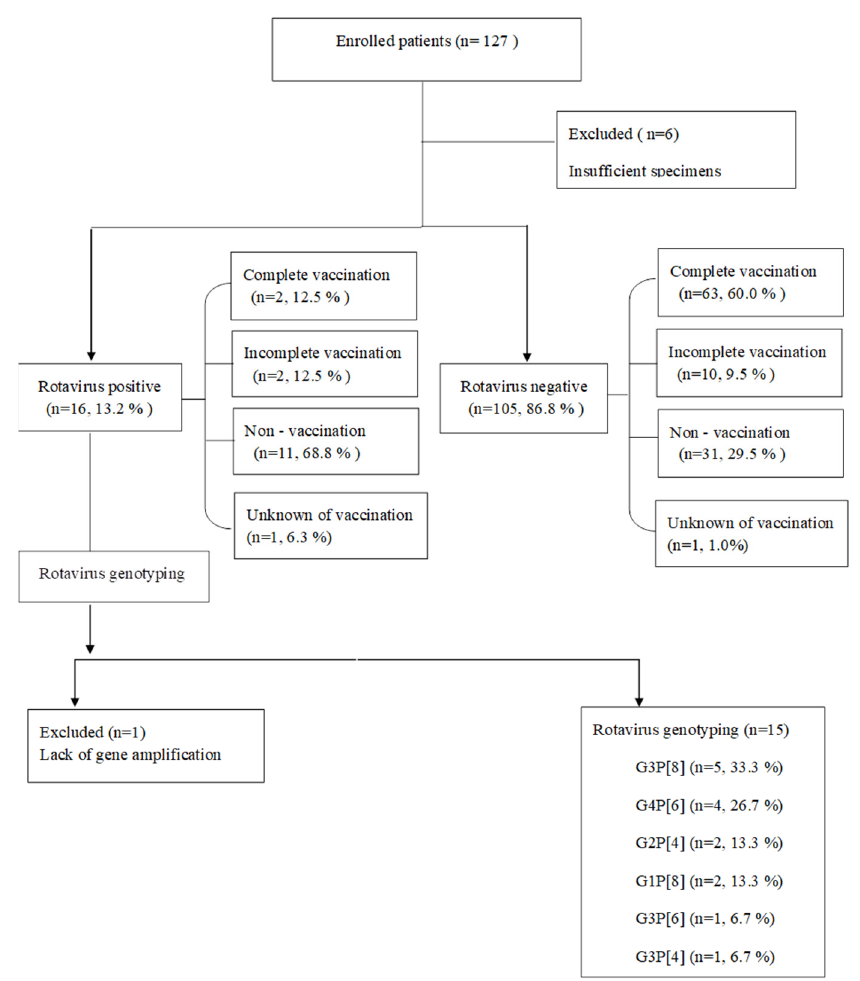
Figure 1. Flow diagram of the study population.